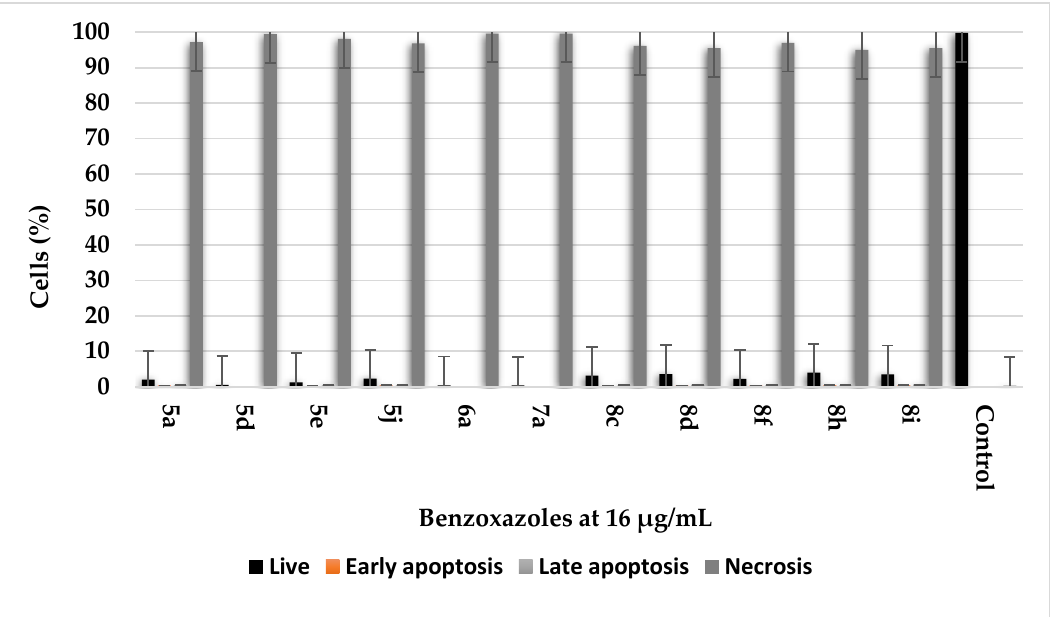
Figure 1. Accidental cell death of C. albicans generated by benzoxazoles. Legend: PI means propidium iodide, PI intercalating strategy to characterize accidental cell death (ACD), % PI-Positivity means % cell death assessed during automated readout using flow cytometry BD FACSLyric 2L6C (BD Biosciences.